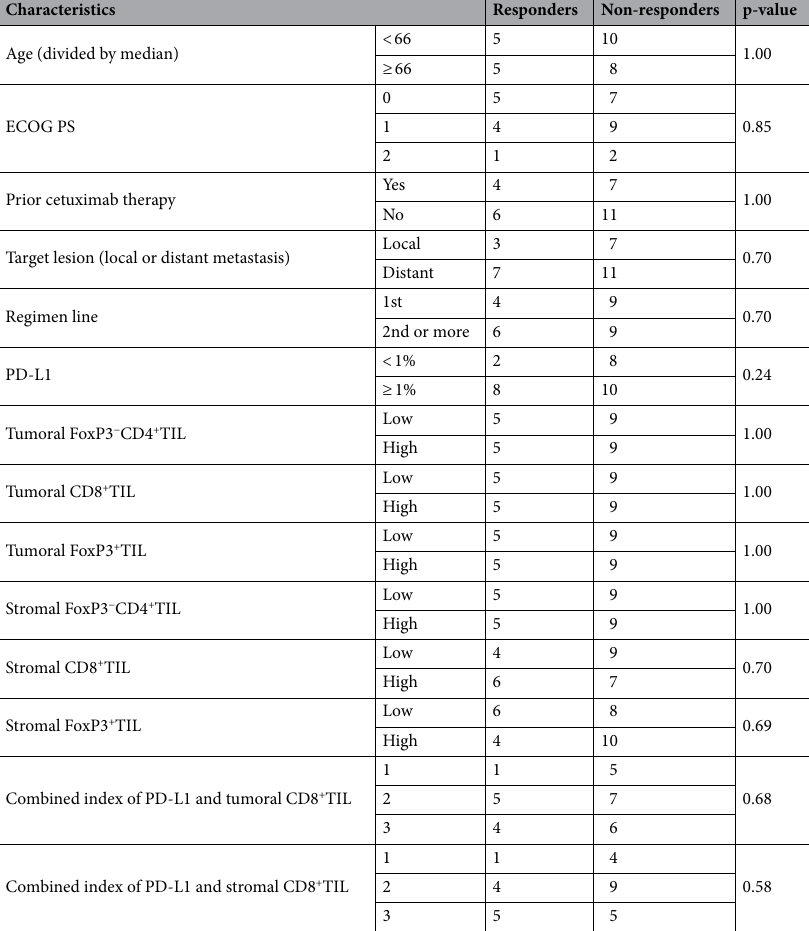
Table 2. Relationship between clinicopathological characteristics and objective response. Patients were classified as responders or non-responders according to objective response to nivolumab. Responders were those who had complete or partial remission as their best response, and non-responders were those with stable or progressive disease.